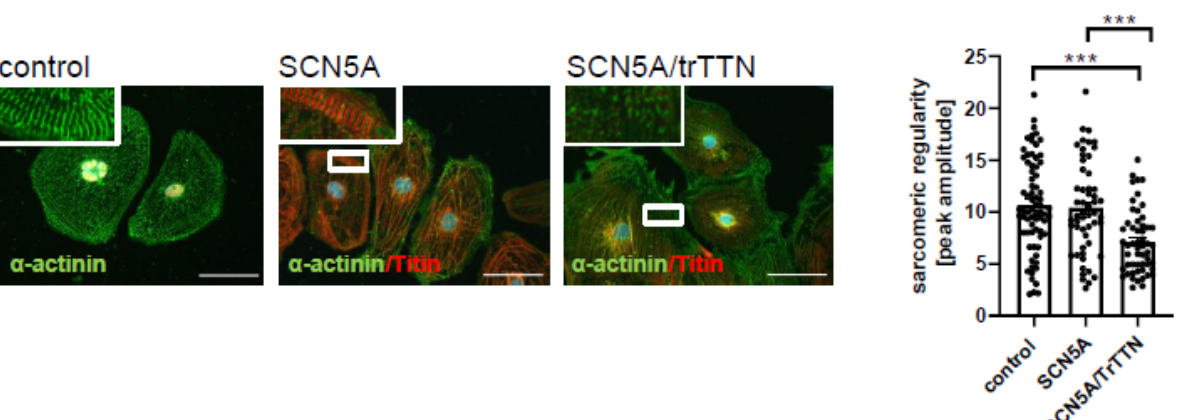
Figure 3. Functional analysis of SCN5a p.C335R variant. ( A ) Na + current traces from Nav1.5 wild-type and p.C335R trans- fected Xenopus oocytes. This showed a loss of function in Nav1.5 p. C335R. Sodium channel currents (INa) were evoked from − 80 mV to 70 mV. Western blot analysis confirmed that the wild-type and mutated Nav1.5 were expressed and that loss of Nav1.5 function was not due to absent expression of the protein. Anti-Rad50 used as a reference. ( B , C ) Representa- tive traces of INa in iPSC-CMs with wild-type and SCN5a p.C335R variant. Sodium channel currents (n = 9) were reduced in iPSC-CMs of the DCM patients.